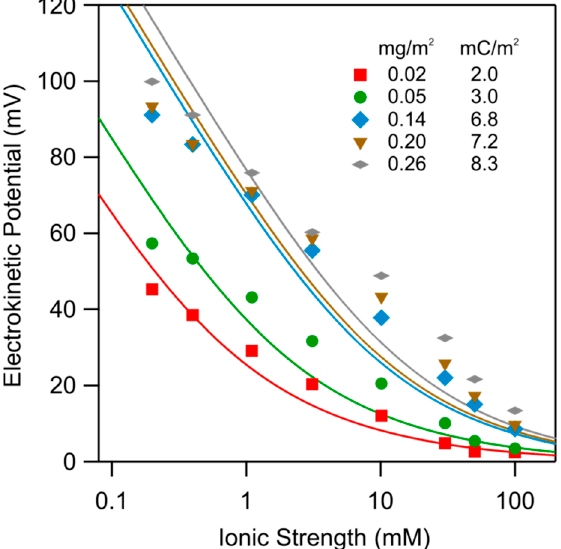
Figure 7. Electrokinetic potential versus the ionic strength of functionalized silica surfaces at pH 4.0 for different adsorbed amount of PDADMAC as indicated. The solid lines are calculations based on the Grahame Equation (1), whereby the indicated surface charge densities were used.